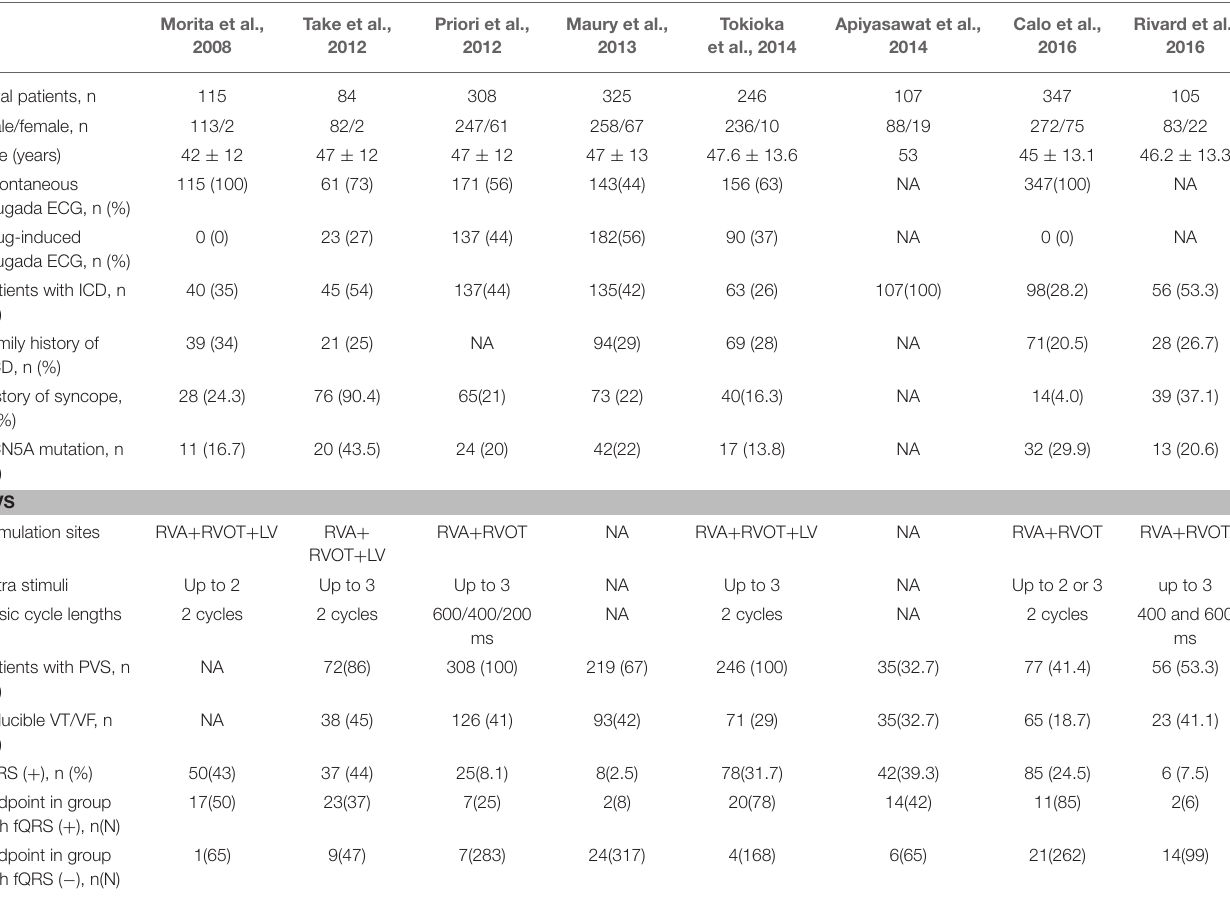
TABLE 2 | Patients’ characteristics of eight included